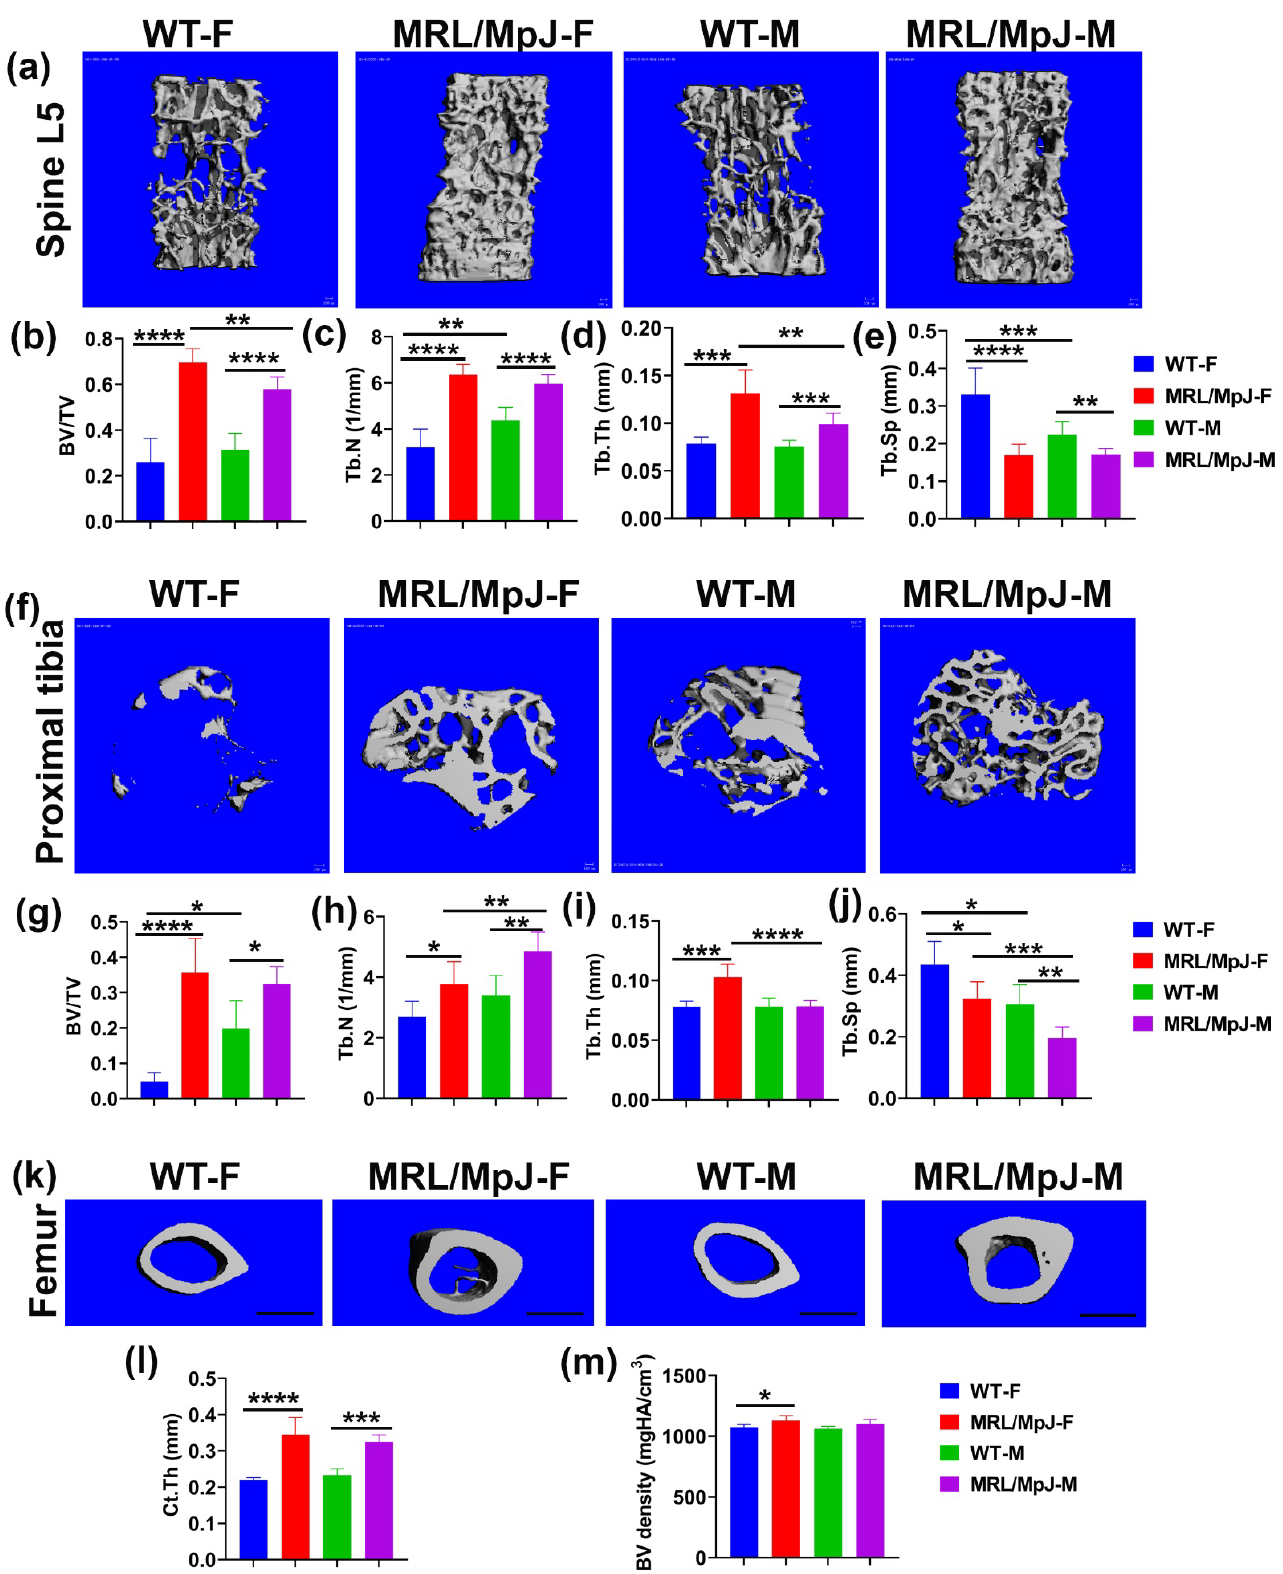
Figure 1. Micro-CT analysis for the lumbar spine, proximal tibia trabecular bone, and femur midshaft cortical bone of 14M wild type (WT) and MRL/MpJ mice. ( a ) Micro-CT 3D view of spine L5 trabecular bone. MRL/MpJ-F and MRL/MPJ-M mice showed markedly higher trabecular bone mass than WT-F and WT-M. Scale bars = 100 µ m. ( b ) BV/TV was significantly higher for MRL/MpJ-F and